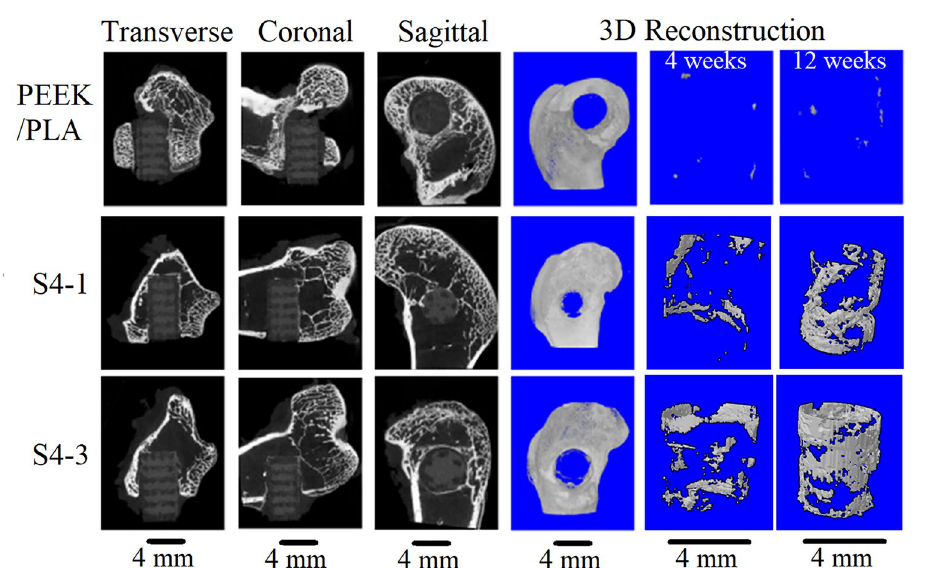
Figure 16. New bone formations of the PEEK/PLA and PEEK-PLA/WS/HA scaffolds as evaluated by micro-CT. 2D (transverse, coronal, and sagittal) radiographs and 3D reconstruction are shown at 4 and 12 weeks after